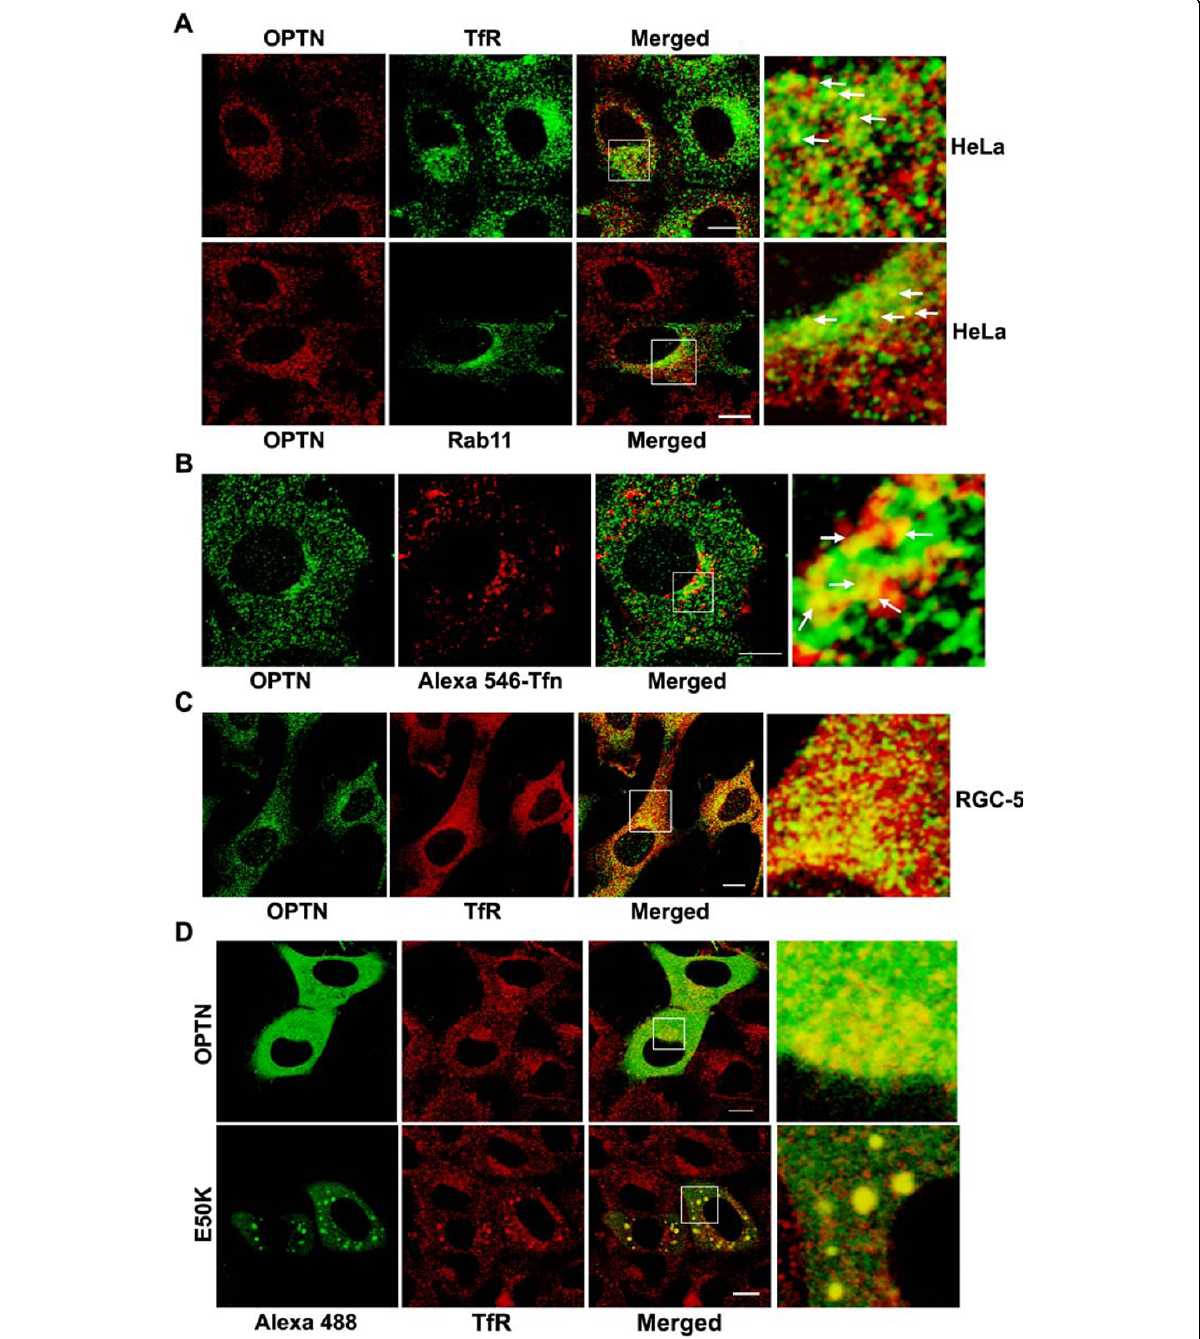
Figure 2 Optineurin is localized to the recycling endosomes . (A) Endogenous optineurin is localized to recycling endosomes in HeLa cells. HeLa cells were stained sequentially for endogenous optineurin and TfR (upper panel) or were transfected with GFP-Rab11 and stained for endogenous optineurin (lower panel). Arrows indicate vesicles showing co-localization. (B) HeLa cells were pulsed with Alexa-546 conjugated transferrin for 30 min, chased with unlabeled holo-transferrin for 20 min and stained for endogenous optineurin. Arrows indicate vesicles showing colocalization. (C) RGC-5 cells were stained for endogenous optineurin and TfR. (D) E50K mutant optineurin forms large vesicles and co- localizes with TfR. HeLa cells were transfected with either E50K mutant or wild-type optineurin expressing plasmids lacking a tag and stained sequentially for optineurin and TfR. E50K mutant optineurin forms large vesicular structures that co-localize strongly with TfR indicated by yellow colour in the merged image. Right panels show enlarged image of boxed area in merged panels. Bar; 10 μ